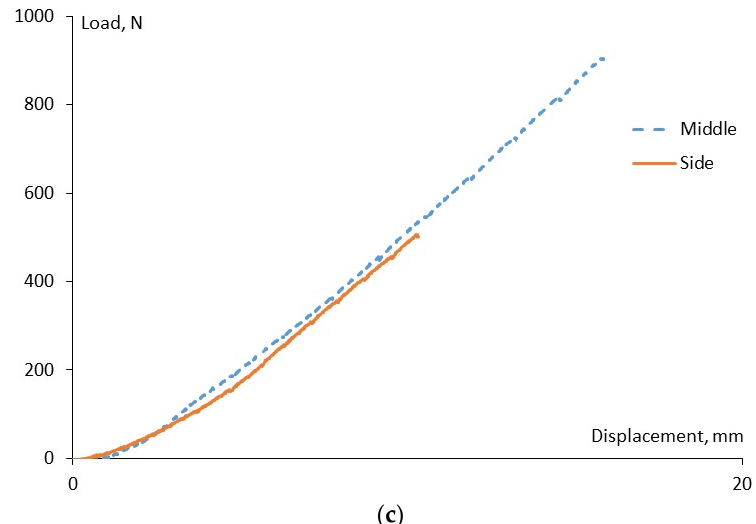
Figure 16. 3D-printed seat folding table before mechanical testing in vertical pull downward applied in the middle ( a ) and on one side ( b ), and associated load-displacement curves for the loading conditions indicated on the graph ( c ).